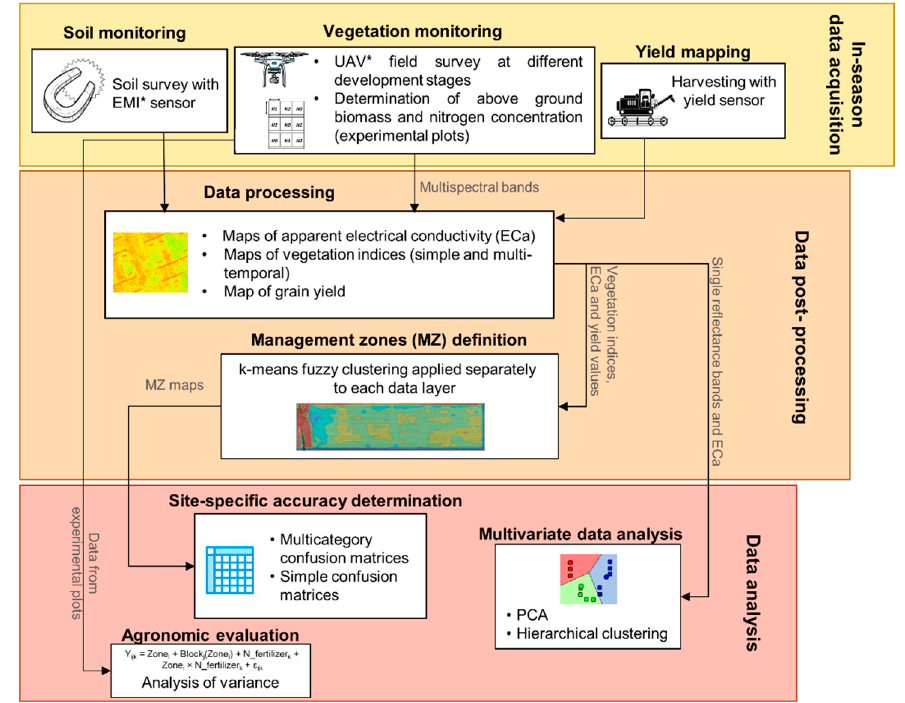
Figure 1. Schematic representation of the activities carried out in the study. * EMI = electromagnetic induction; UAV = unmanned aerial vehicle; ECa: apparent electrical conductivity; MZ: management zone.